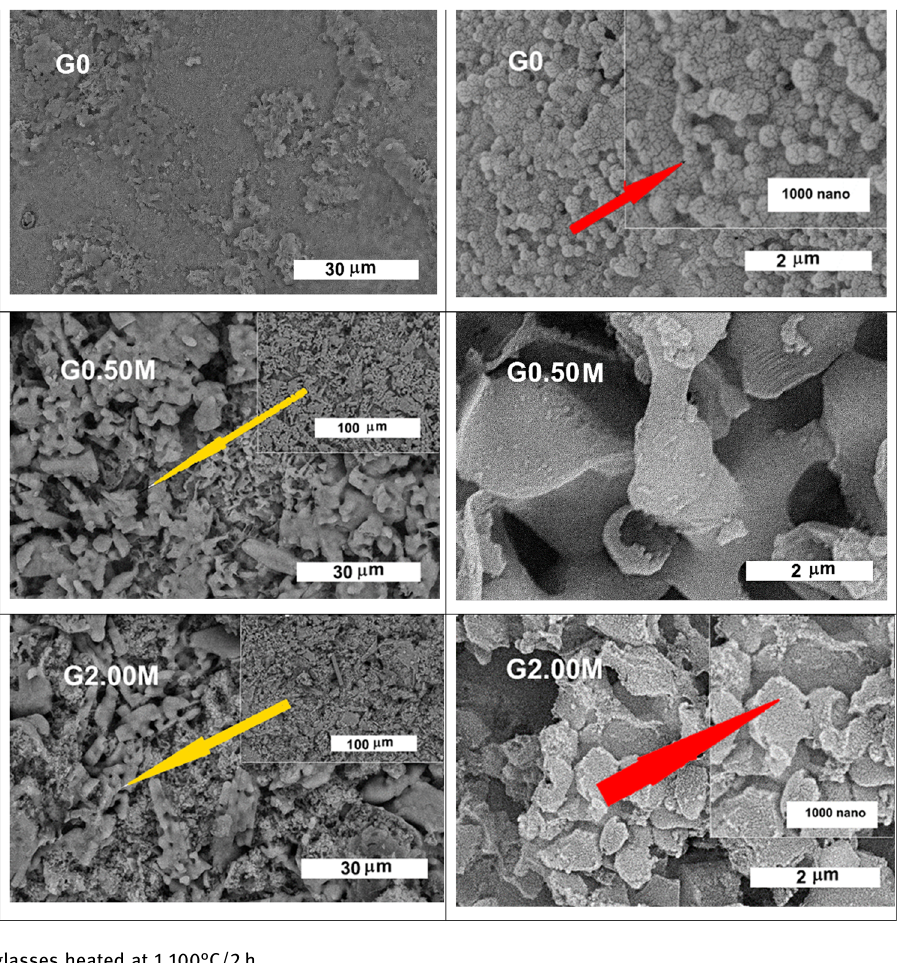
Figure 3: XRD of glasses heated at 1,100°C/2 h.